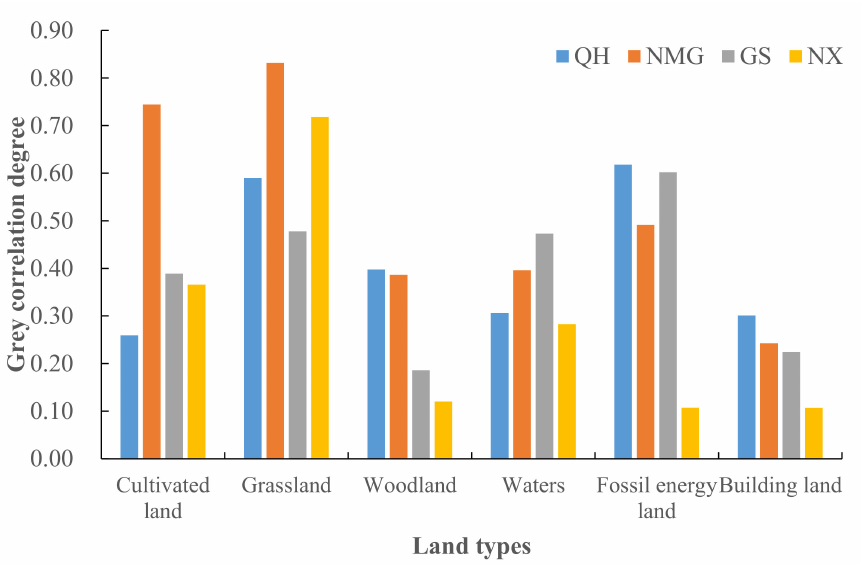
Figure 8. Grey correlation degree between ecological productive land consumption and per capita ecological